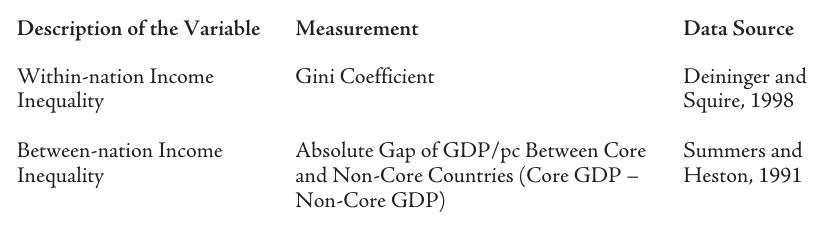
Table 2 – Data Summary Figure 1 – GDP/pc for a Sample of Core and Non-core